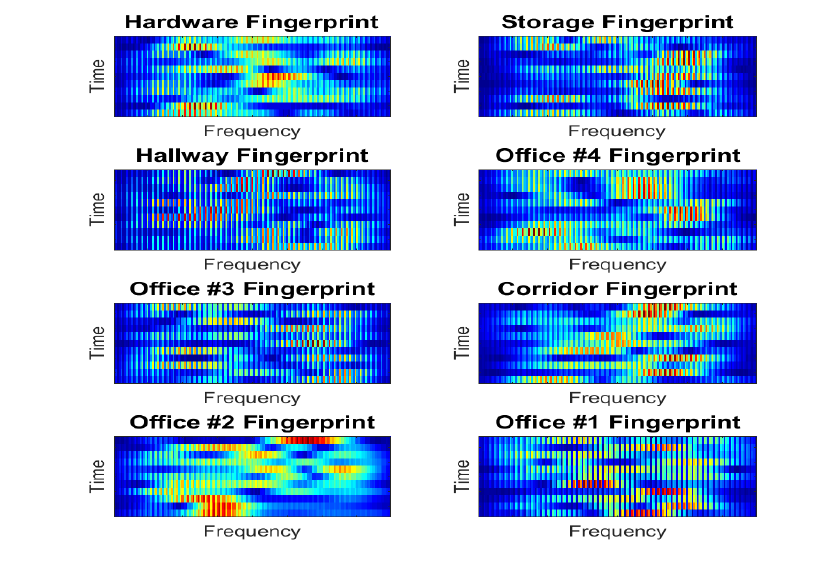
Figure 5. STFT-generated fingerprints recorded by the TDVS from one non-cooperative emitter location inside each room of the indoor